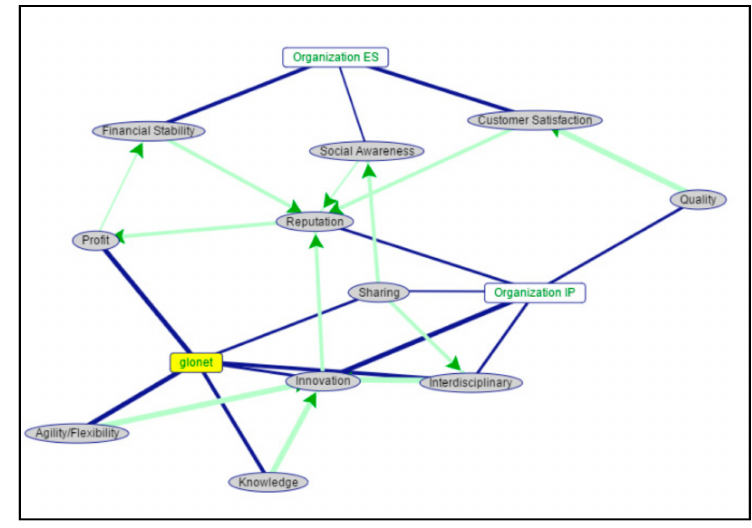
Figure 8. Partial network cores values map.